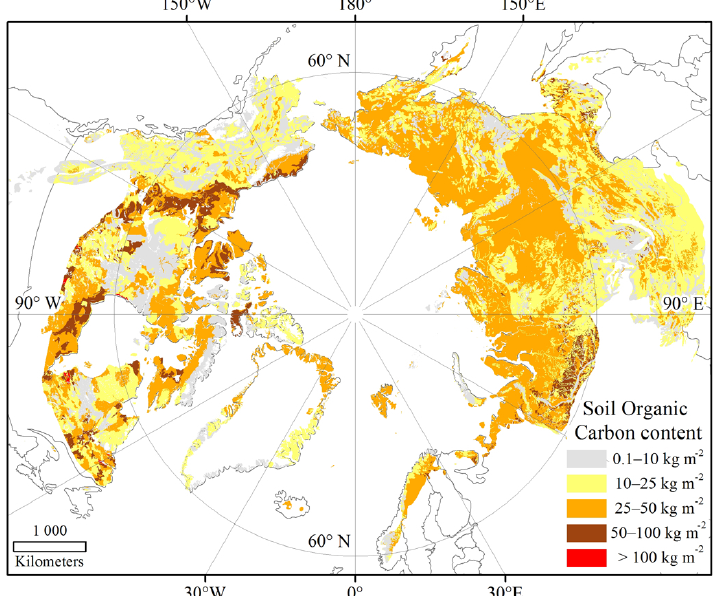
Figure 1. Map showing the spatial extent of the NCSCD and the estimated SOCC to a depth of 1m. Layout adapted from Tarnocai et al. (2007). Projection North Pole azimuthal equidistant (datum: WGS 84). Table 1. Data sources for the soil maps constituting the spatial base of the NCSCD. Country or region Scale Soil map type Reference USA 1 1:250000 Digital Soil Survey Sta ff (1997) Canada 1:1000000 Digital Tarnocai and Lacelle (1996) Russia 1:2500000 Printed Fridland (1988); Naumov (1993) Kazakhstan 1:2500000 Printed Uspanov (1976) Mongolia 1:3000000 Printed Dorzhgotov and Nogina (1990) Greenland 1:7500000 Printed Jakobsen and Eiby (1997) Scandinavia 2 1:1000000 Digital European Soil Bureau (1999) Iceland 1:1500000 Printed Arnalds and Gretarsson